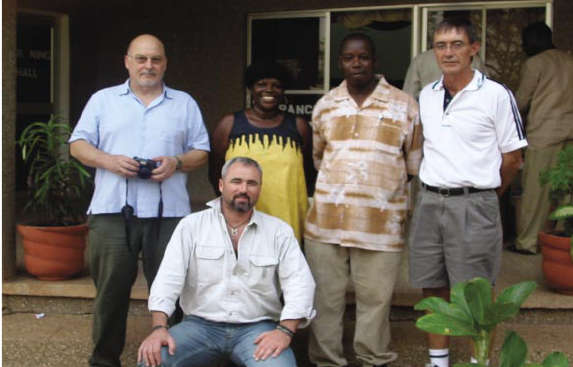
Figure 8 . The observers with the Chief Director of NFED. From left to right Lawrence Jenkin, Agnes Addo-Mensah, Samuel S Mogre (Director NFED) and me. In front is Gilberto